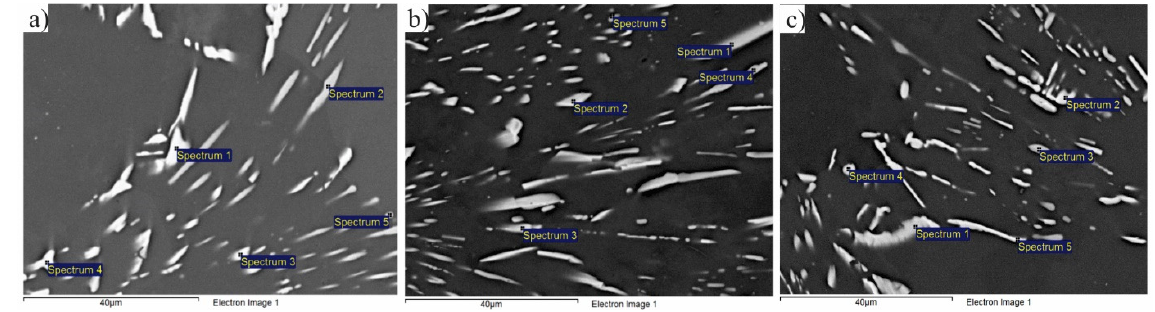
Figure 8. SEM micrographs of samples homogenized for 4 h ( a ), 6 h ( b ) and 12 h ( c ) at a temperature of 600 °C, wherein EDS analysed spots are marked. Table 4. EDS results showing different phases present in the investigated samples from Figure 8 in at. %.